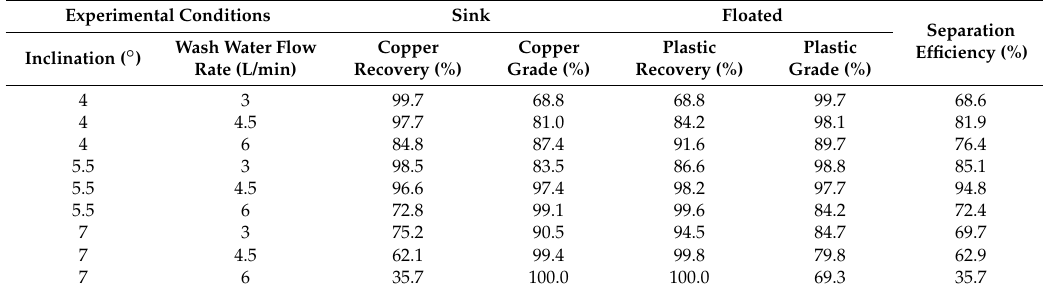
Table 4. Experimental matrix and results of shaking table separation (average of three replicates).